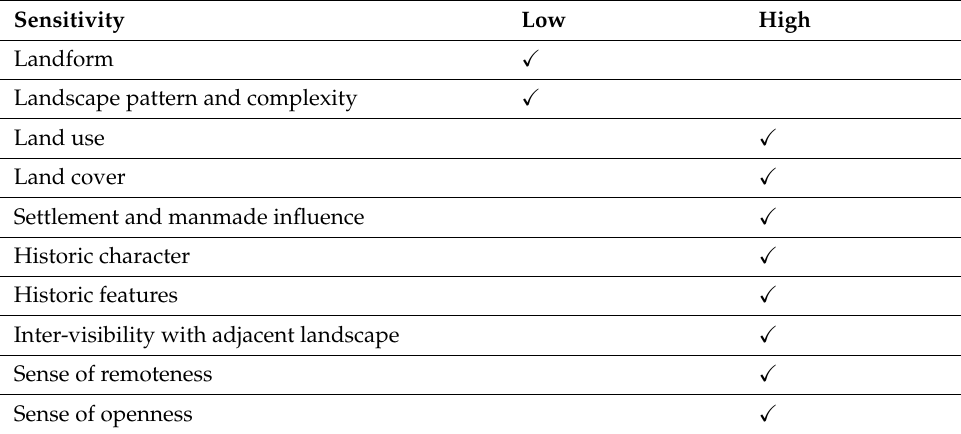
Table 5. Sensitivity of landscape factors for